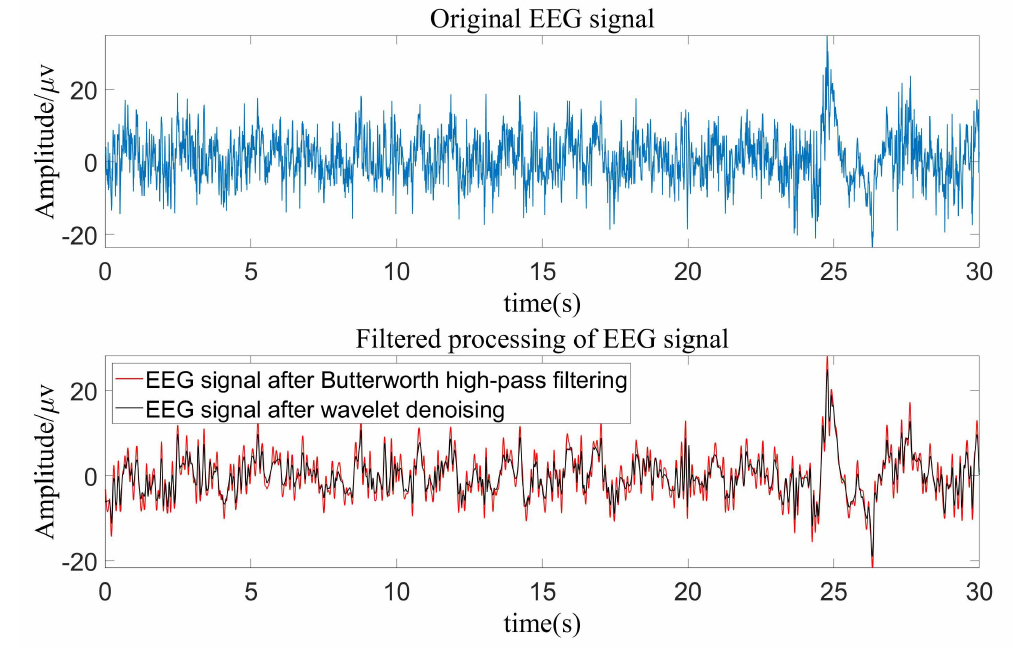
Figure 2. Original EEG signals and filtered processed EEG